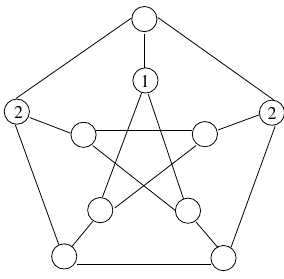
Figure 4: An antiregular dominating labeling of the Petersen